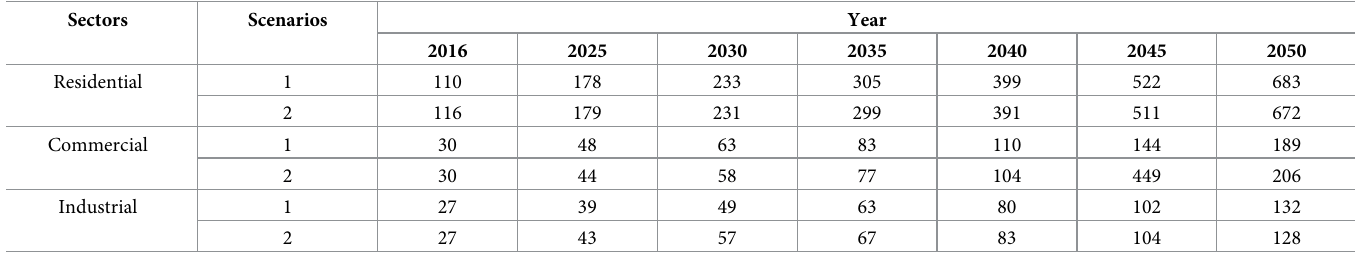
Table 6. Water consumption based on